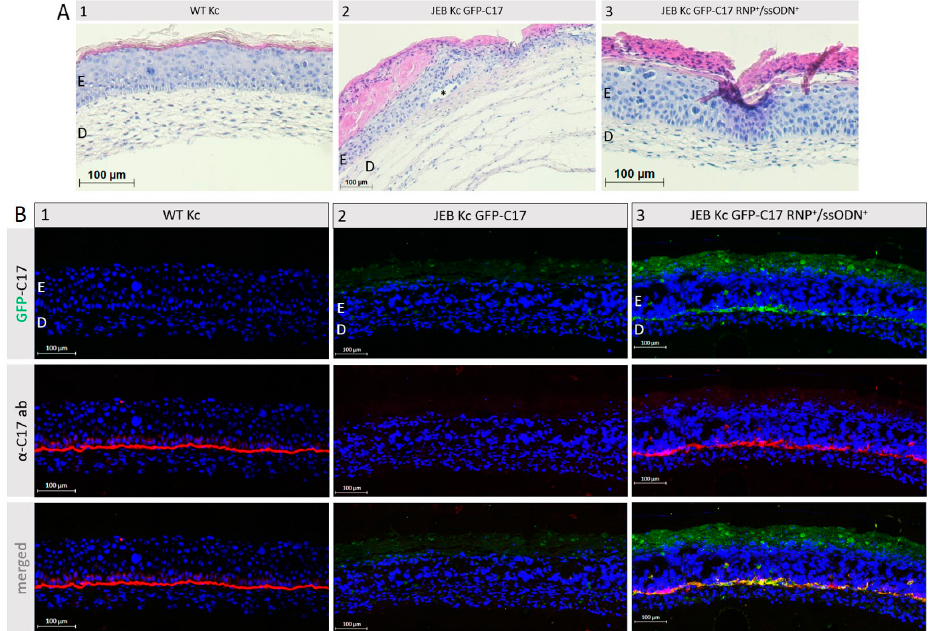
Figure 6. GFP-C17 restoration within the BMZ of JEB-derived skin equivalents. ( A ) H&E staining of skin equivalents, expanded from WT Kc (1) as well as untreated (2) and RNP/ssODN-treated (3) GFP-C17 mut -expressing JEB cells, revealed a normal epidermal stratification, although in SEs derived from untreated GFP-C17 mut -expressing JEB cells a blister (*) was detectable within the BMZ. E = Epidermis ; D = Dermis. ( B ) Immunofluorescence staining performed on cryosections showed an accurate C17 expression (red fluorescence) in the BMZ of SEs derived from WT keratinocytes (1). SEs from untreated GFP-C17 mut -expressing JEB Kc showed no visible GFP-C17 and C17 expression (2), whereas immunofluorescence staining of 3D SEs expanded from RNP/ssODN-treated (~11% GFP-C17 pos ) JEB cells revealed the accurate deposition of GFP-C17 (green fluorescence) within the BMZ overlapping with immunolabelled C17/GFP-C17 (3). The cell’s nuclei were stained with 4’, 6-Diamidino-2-phenylindol (DAPI, blue).